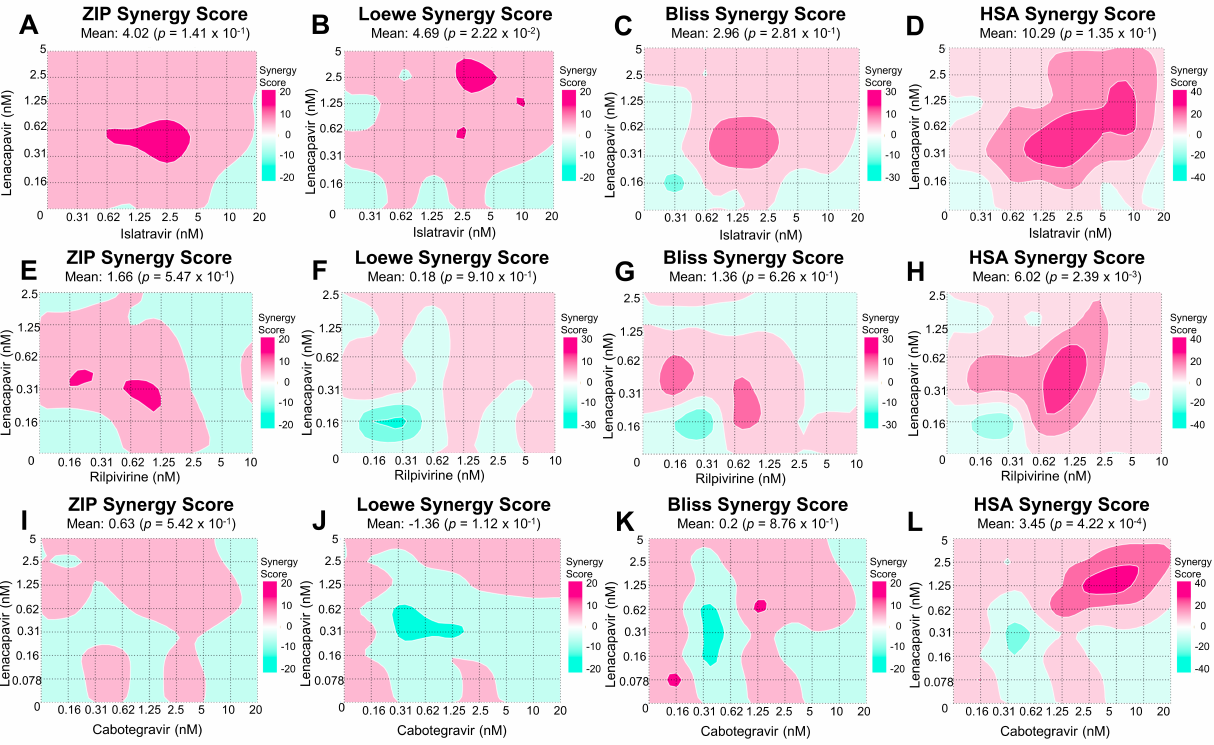
Figure 2. Synergy scores and matrices of LEN and ISL, RPV, or CAB. Above demonstrates the various synergy scores at each individual dose-response point, as well as the overall synergy score for ZIP, LOEWE, BLISS, and HSA. Each row represents different drug combinations: ( A – D ) LEN and ISL, ( E – H ) LEN and RPV, and ( I – L ) LEN and CAB. Each drug combination was performed in TZM-GFP cells, where dose-response matrices were pre-incubated 24 h with the cells. After, cells were incubated with NL4-3 and 48 h post infection the cells were imaged for GFP ( A – H ). Cells treated with LEN and CAB were lysed and read for luciferase signal ( I – L ). Furthermore, percent inhibition was calculated (as seen in Figure 1), and then input into SynergyFinder Plus, where these 2D contour plots, synergy scores, and mean synergy scores were